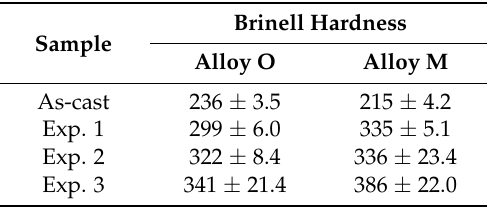
Table 3. Hardness of the as-cast and austempered samples as the average of five tests for each.